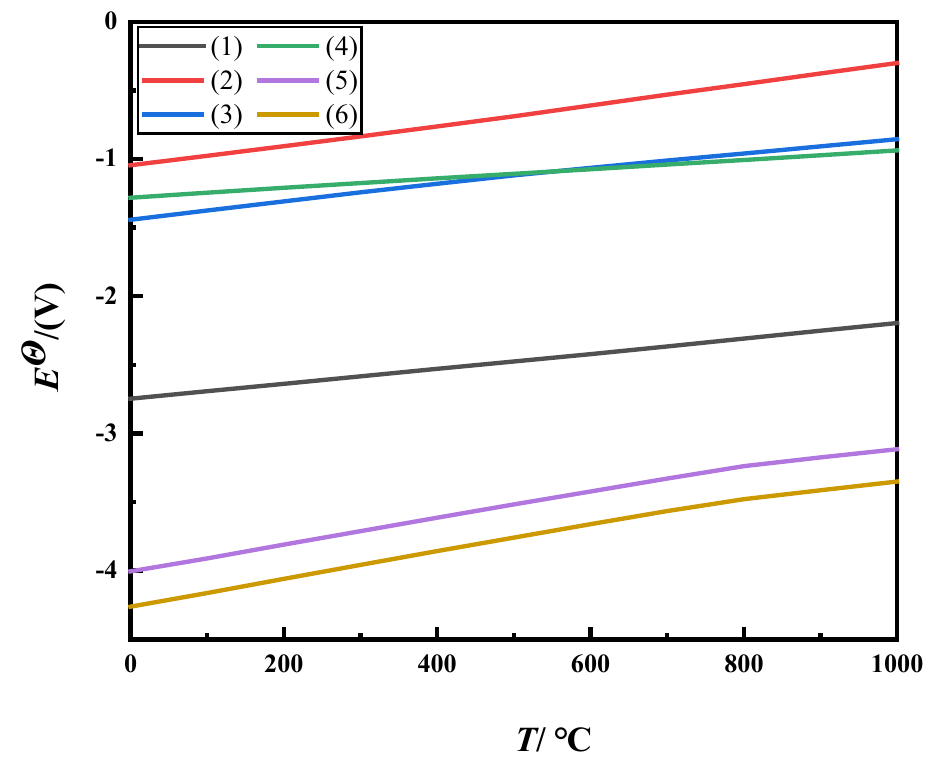
Figure 1. E Θ − T diagram of electrochemical reactions that may occur in the process of electro-deoxi- dation.